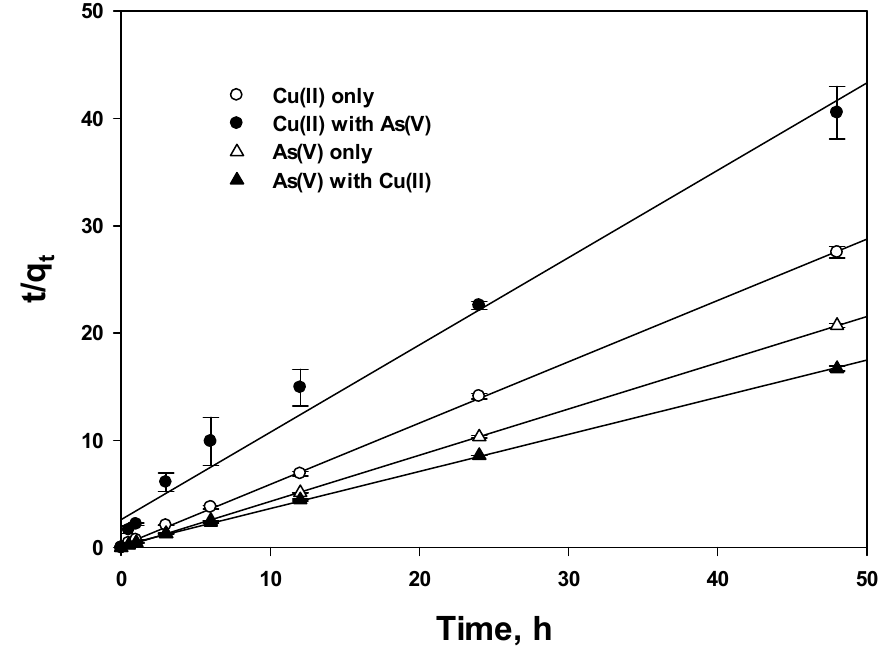
Figure 6. Linear PSO model for Cu(II) and As(V).